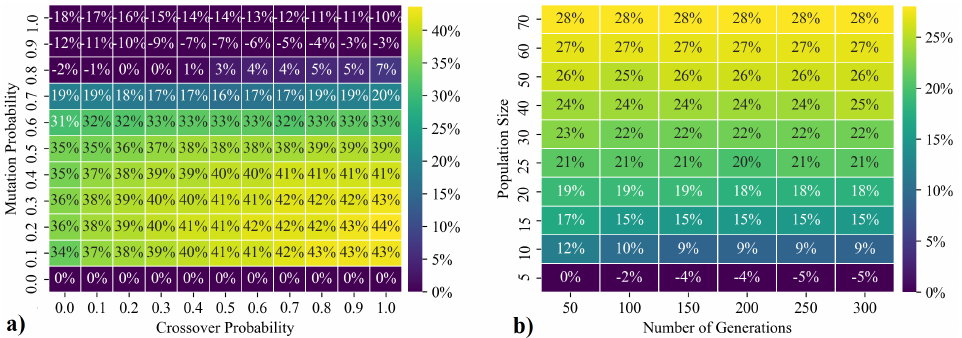
Figure 3. Parameter variation genetic algorithm without constrains. ( a ): Dependency on mutation and crossover probabilities for all population sizes and number of generations; ( b ): Dependency on population size and number of generations for all mutation and crossover probabilities.